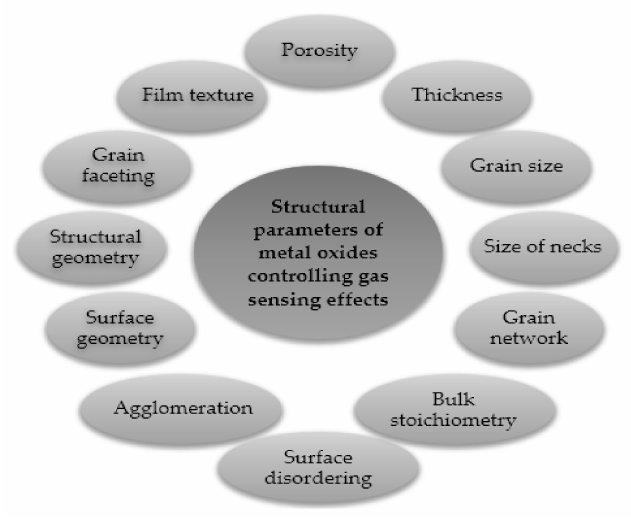
Figure 5. MOXs features that influence their gas-sensing properties. Elaboration from reference [31]. In the case of porous layers, there are three possibilities for the necks between grains, including surface/bulk, grain boundary and flat bands, which are for enough large necks, large grains not sintered together and small grains with small necks, respectively (Figure